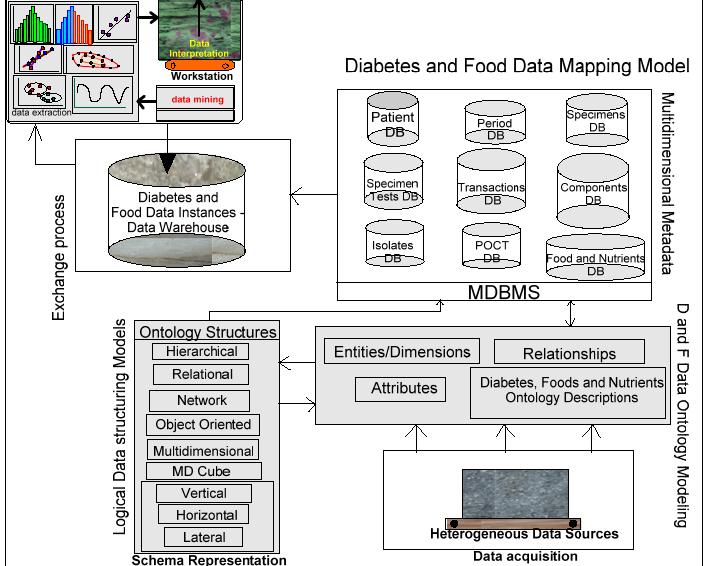
Figure 8. An integrated framework for connecting the diabetes and food